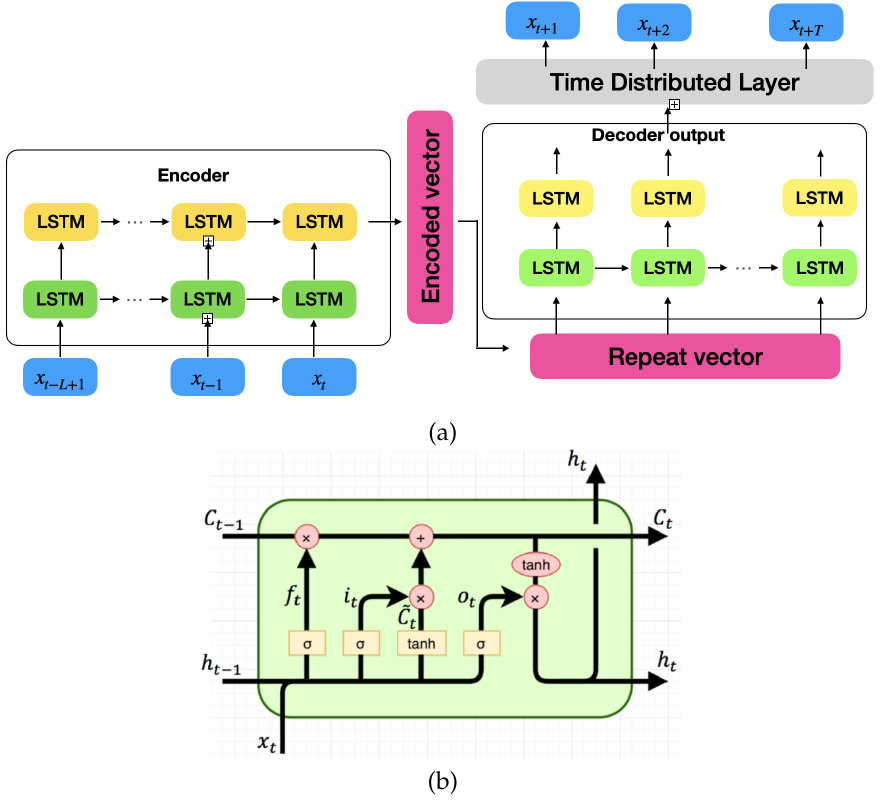
Figure 6. Proposed model for human hand motion prediction, ( a ) shows the architecture of the encoder–decoder LSTM neural network, and ( b ) shows the overview of LSTM cell